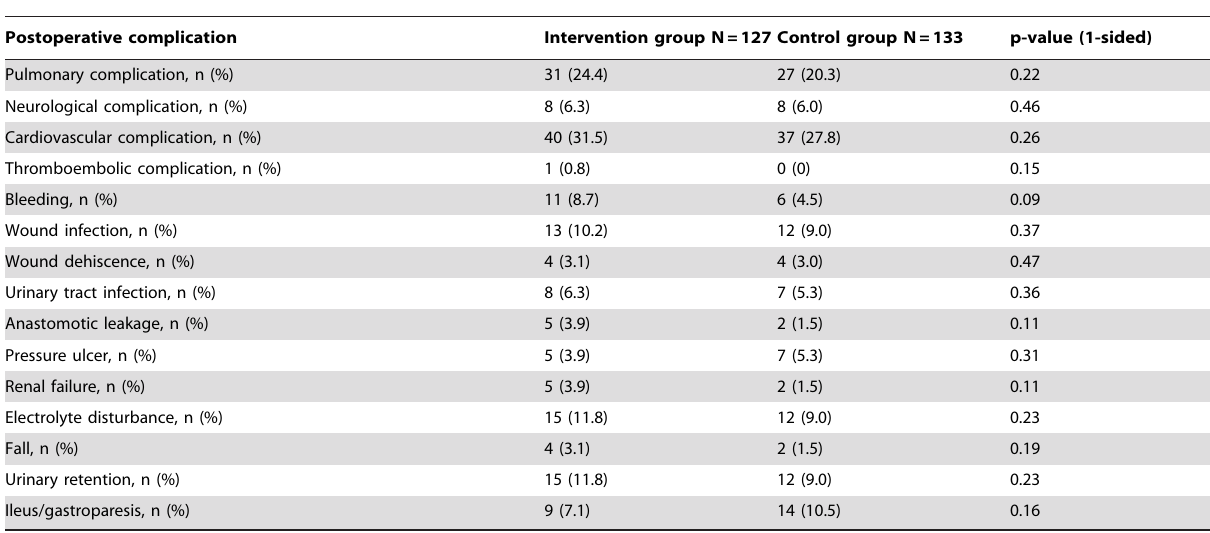
Table 6. Number of patients with complications according to study